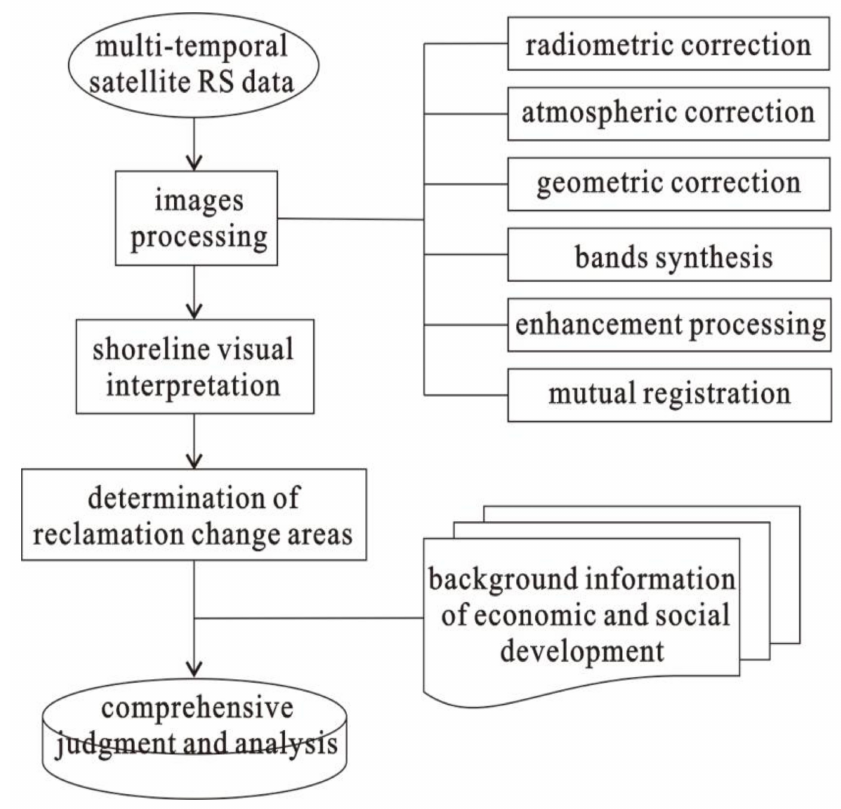
Figure 3. Flow chart of the